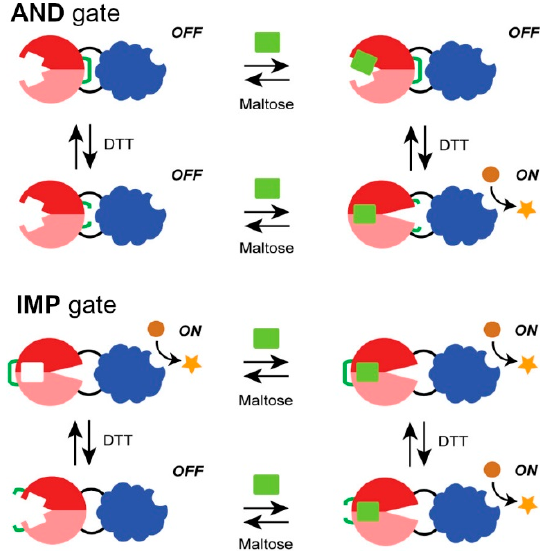
Figure 2. Redesign of logic gates using engineered disulfide bridges. The activity of BLA (blue) is dependent on the ability of MBP (red) to bind to maltose. In the AND gate design, a disulfide bond (green) holds the MBP domain in an open conformation, preventing the conformational change in MBP necessary to activate BLA. Addition of the DTT reducing agent breaks the disulfide bond to allow the MBP conformational change and BLA activation to occur. In the IMP gate design, the engineered disulfide bond now holds MBP in the closed conformation, such that BLA is always activated unless DTT is present and maltose is absent. This figure is adapted and reprinted with permission from Choi, J.H. and Ostermeier, M. 2015. Rational design of a fusion protein to exhibit